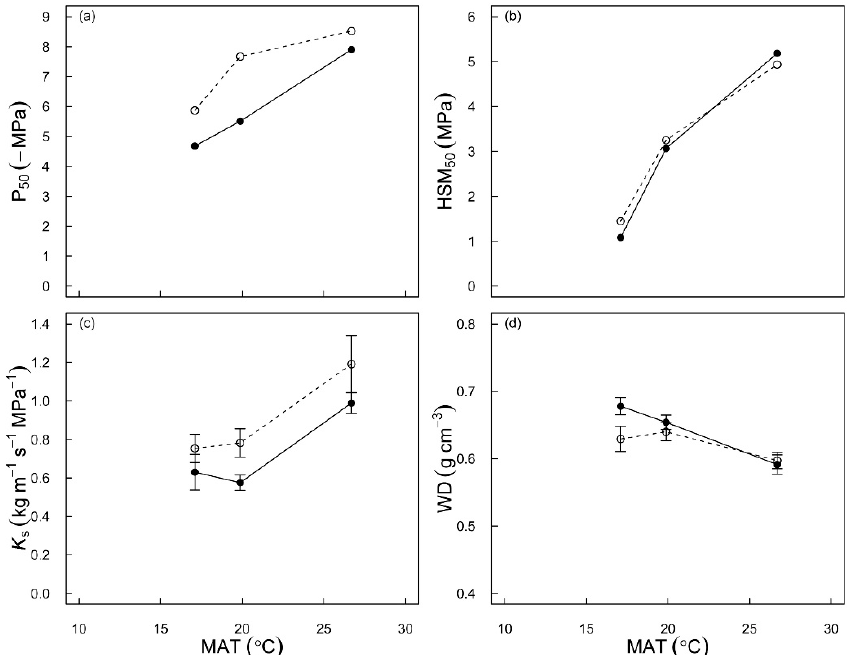
Figure 2. The variations of hydraulic traits (( a ) water potential at 50% loss of conductivity, P 50 ; ( b ) hydraulic safety margin, HSM 50 ; ( c ) sapwood-specific hydraulic conductivity, K S ; ( d ) wood density, WD) across two mangrove species in three sampling sites with different mean annual temperature (MAT; °C). Open circles represent Avicennia marina and filled circles represent Aegiceras corniculatum . Error bars indicate standard error of mean. Table 3. Values of key hydraulic traits of two mangrove species across three sample sites. Hydraulic traits are shown as mean ± standard error (SE, n = 5 except MVL, which is n = 3). K L : leaf specific hydraulic conductivity (kg m − 1 s − 1 MPa − 1